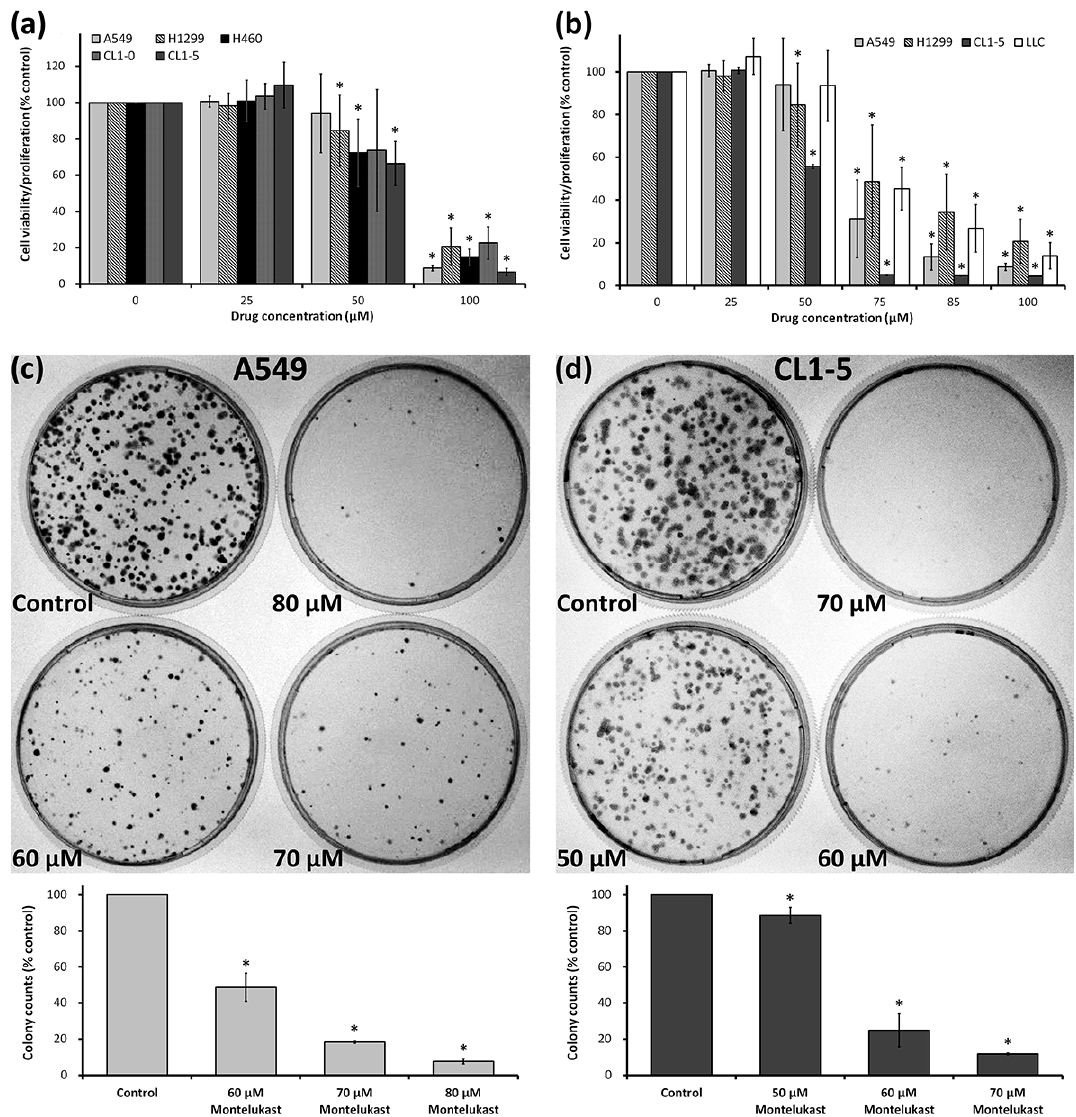
Figure 1. Montelukast inhibited the viability/proliferation of lung cancer cells. ( a , b ) The cells were treated with various concentrations of montelukast for two days. Cell proliferation/viability was determined by a Premixed Water-Soluble Tetrazolium Salt-1 (WST-1) Cell Proliferation Assay; ( c , d ) after being treated with various concentrations of montelukast for a day, the cells (A549 and CL1-5) were incubated for nine days and the colonies on each dish were counted. All results were expressed as the mean ± SD of independent experiments performed on different days. * p < 0.05, as compared with the corresponding control (0 µ M) group.